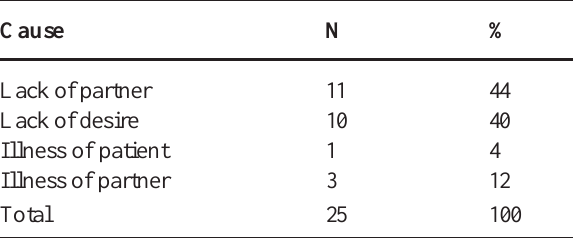
Table 2 – Causes of absence of sexual activity.